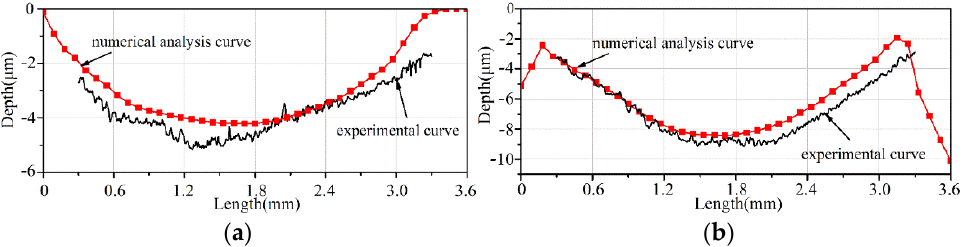
Figure 20. Inner surface axial profile curve of C-ring after 14.4 km working distance. ( a ) Opposite side to offset; ( b ) Offset side.